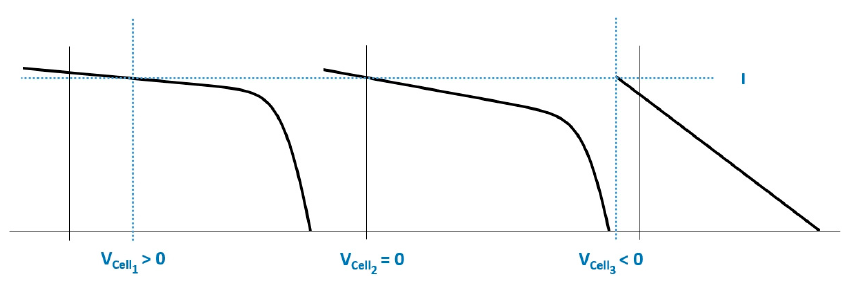
Figure 14. Cells connected in series (same current) working at different voltages.